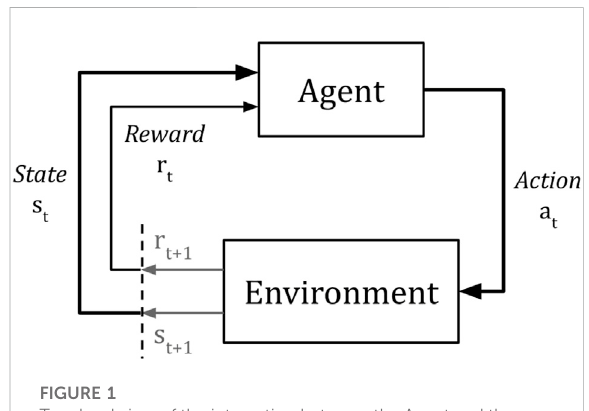
FIGURE 1 Top-level view of the interaction between the Agent and the